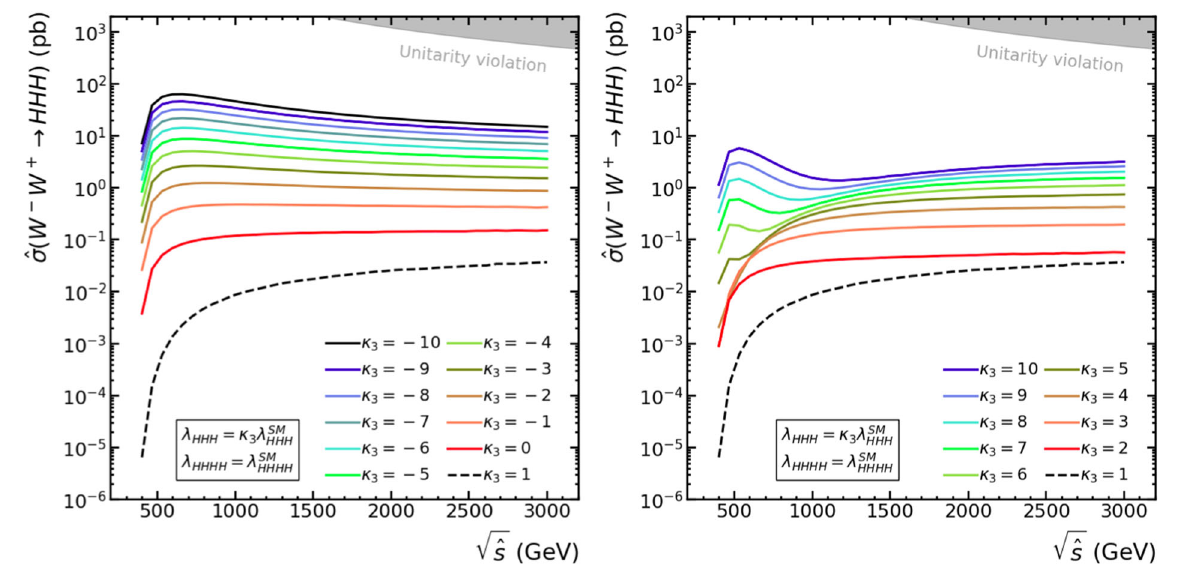
Fig. 13 Total cross section of the W − W + → H H H subprocess as √ ˆ s for different values of the parameter a function of the CM energy κ κ 3 , with 4 fixed to 1, compared to the SM prediction (dashed line).